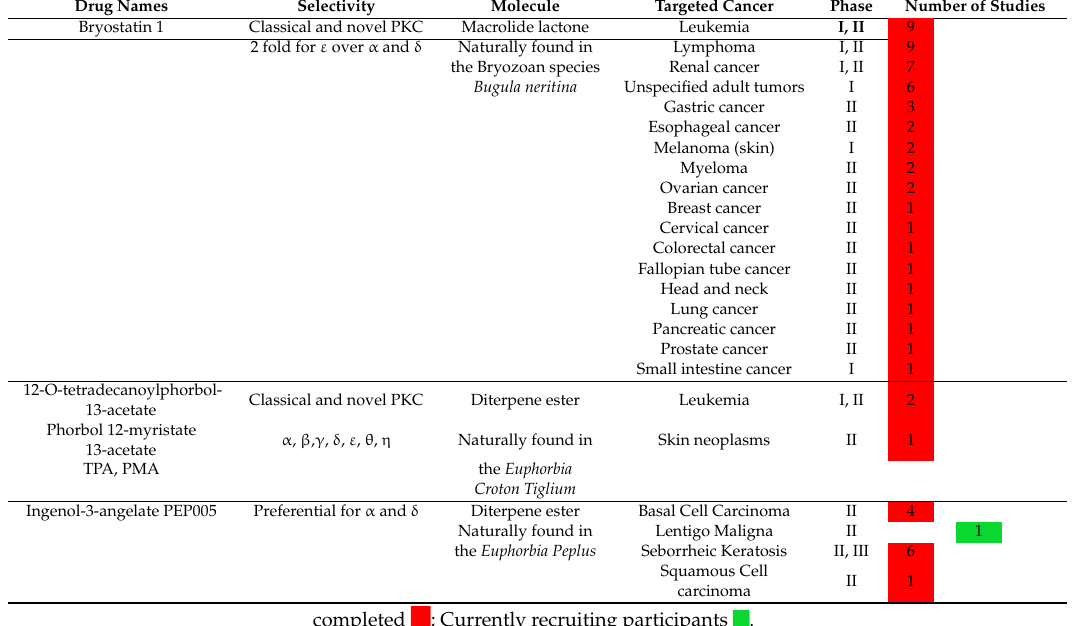
Table 1. Clinical trials of natural PKC activators in human cancers (https: // clinicaltrials.gov /